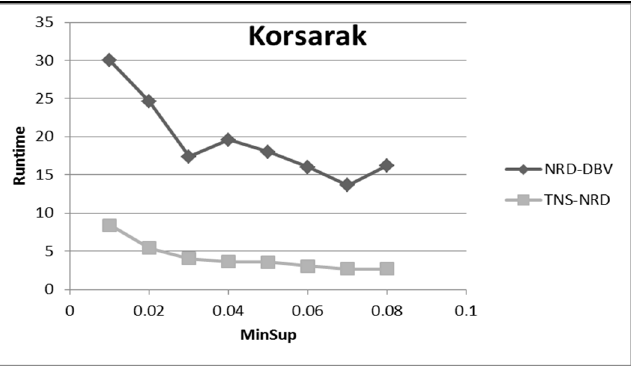
Figure 19. Comparison of the runtime of the TNS with the TRuleGrowth for (Korsarak) dataset.